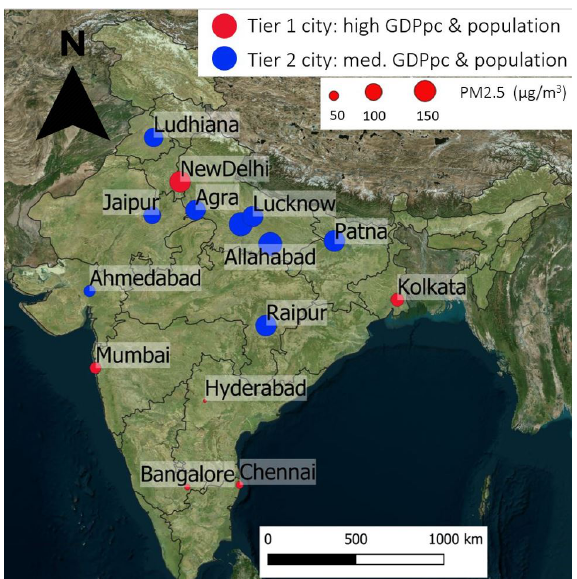
Figure 2. Study location of this research showing PM2.5 concentrations in cities with high and medium GDP per capita (GDPpc) and population size, formally known as Tier-1 (shaded in red) and Tier 2 (shaded in blue) cities respectively. Label size correspond to annual mean PM 2.5 concentrations in the year 2016 as per WHO database